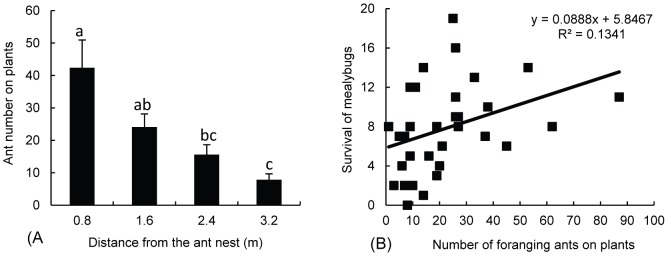
(A) Number of foraging workers (mean±SE) of S. invicta at different distances from the ant colonies and (B) its correlation with the number of mealybugs present in shelters.Bars labeled with the same letter are not significantly different from each other (p>0.05, Mann–Whitney test).